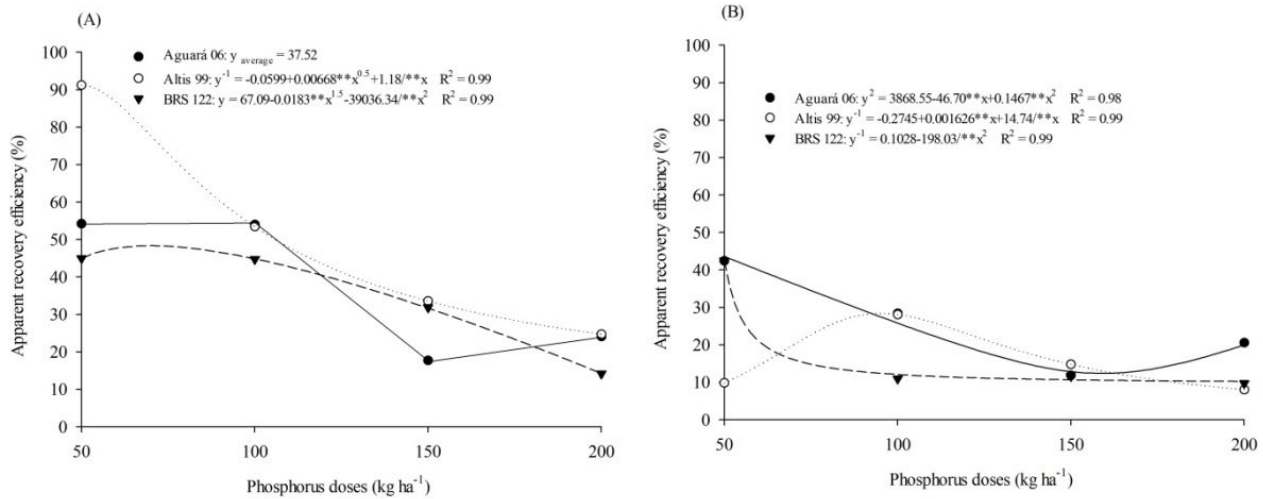
Figure 4. Apparent recovery efficiency of sunflower as a function of phosphorus doses in the 2016 agricultural season ( A ) and 2017 agricultural season ( B ).